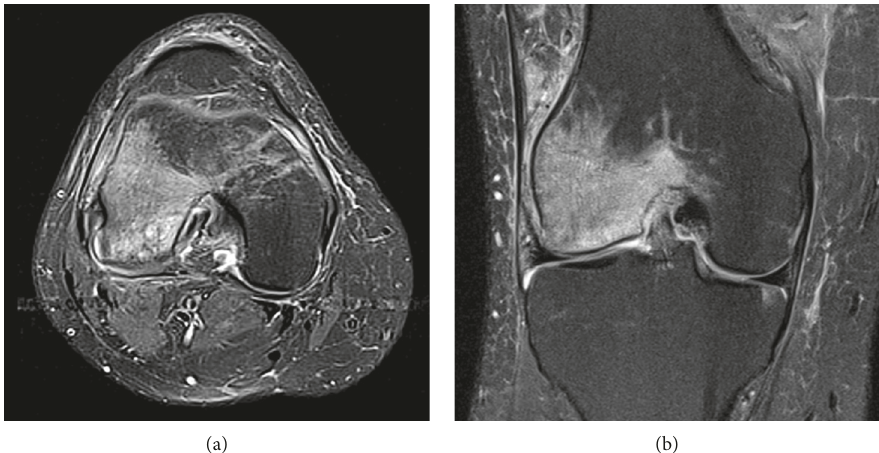
Figure 2: MRI (T2 Fat Sat; (a) axial and (b) coronal views) showing lateral and medial femoral bone oedema (osteochondral collapse of lateral femoral